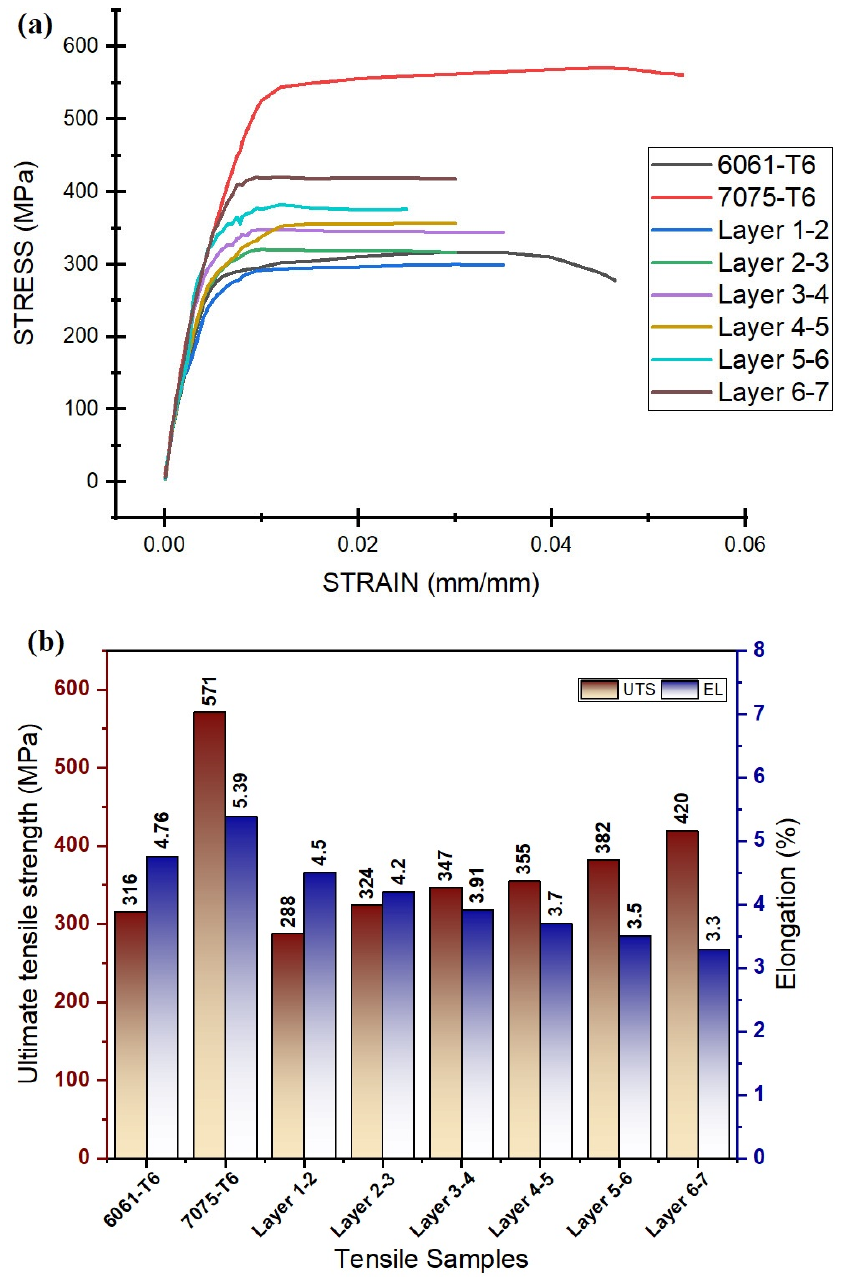
Figure 15. Tensile test results: ( a ) stress–strain curve; ( b ) UTS and elongation %.